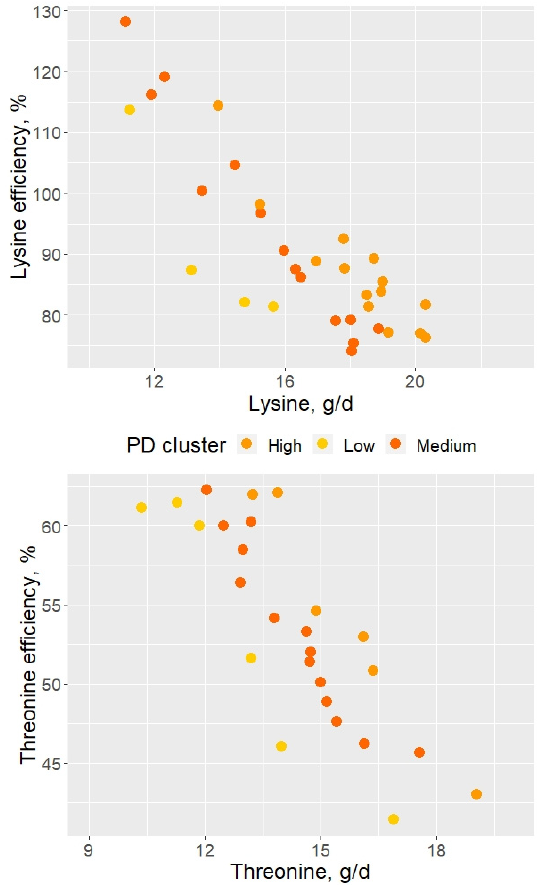
Figure 4. Amino acids efficiency of utilization for protein deposition above maintenance as a function of the amino acid intake. Table 5. Mixed model coefficients used to explore the variance in Lysine (Lys) and Threonine (Thr) efficiency of utilization above maintenance as a function of the amino acid intake using a Bayesian approach, where the protein deposition cluster was considered a random effect.